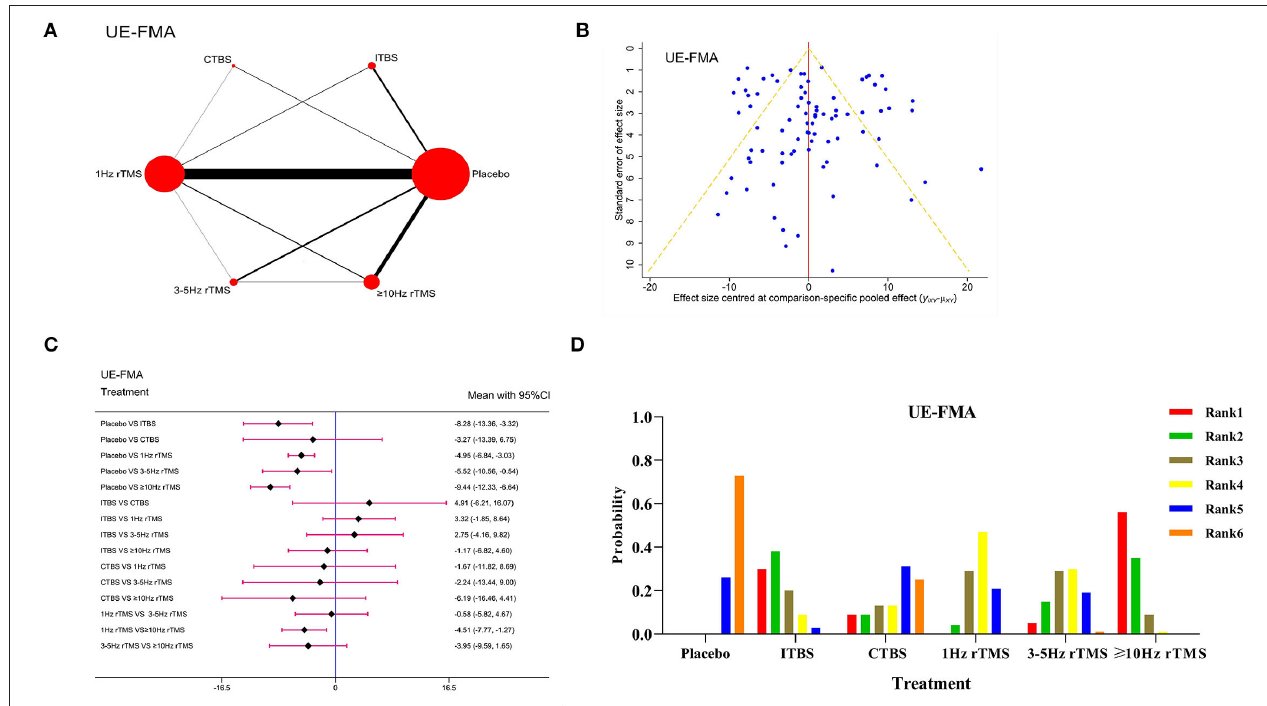
FIGURE 2 | Network meta-analysis results for Upper Extremity Fugl-Meyer Assessment (UE-FMA). (A) : Network plot; (B) : Funnel plot; (C) : Forest plot; (D) : The figure of ranking